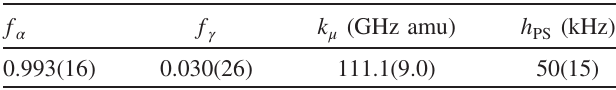
TABLE IX. Best-fit parameters for 3D King relation with the PS term as an origin of the nonlinearity. The error of each fit parameter is evaluated as 1 σ .